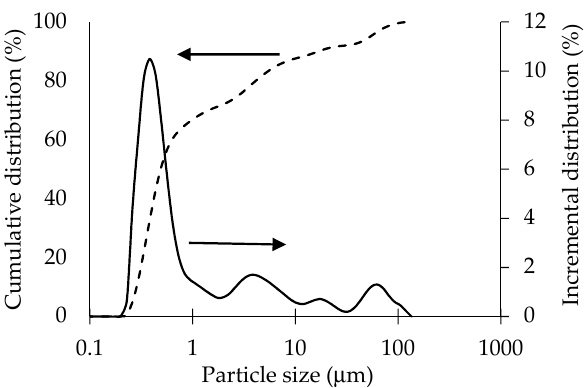
Figure 1. Particle size distribution of CB VULCAN 7H determined by laser granulometry.